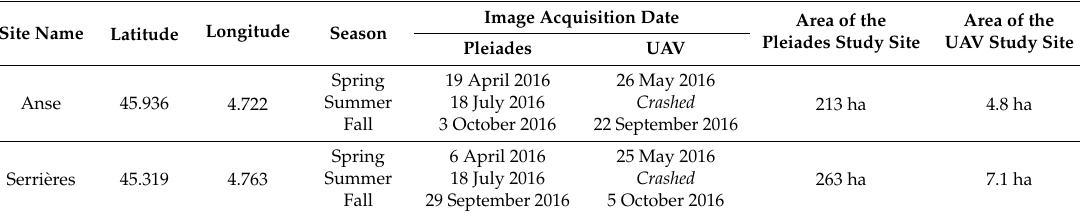
Table 1. Overview of satellite and UAV images used in the classifications for each study